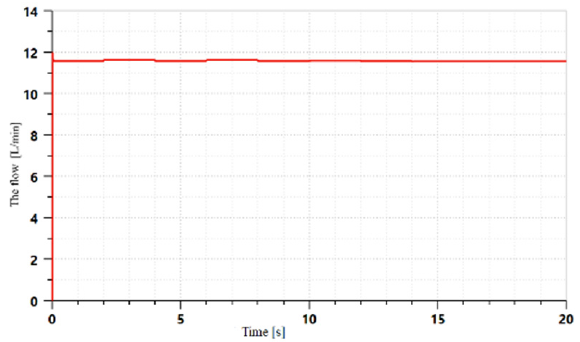
Figure 14. Viscous damping coefficient of 20 N/(m·s).